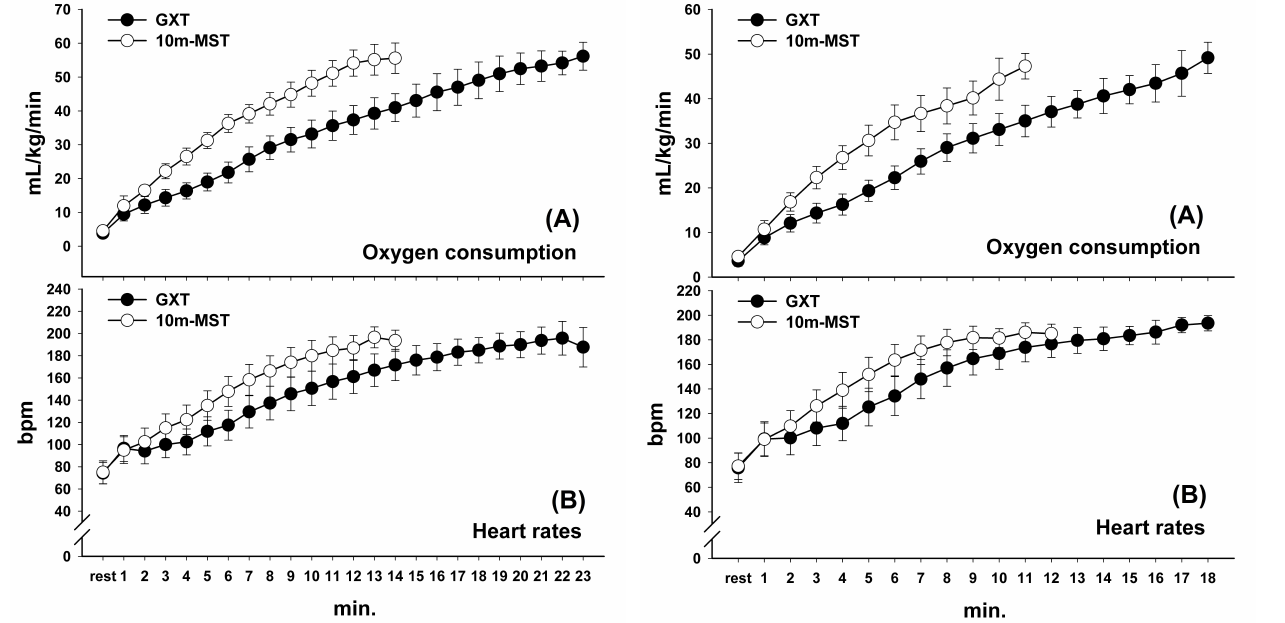
Fig. 2. Oxygen uptake and heart rates comparison of GXT and 10-m MST in females. GXT means gradually maximal ex- ercise test and MST means multistage shuttle-run test. The X-axis is exercise duration time by the minute, and the Y-axis of (A) is oxygen consumption during exercise, and the Y-axis of (B) is heart rate per minute during exercise.